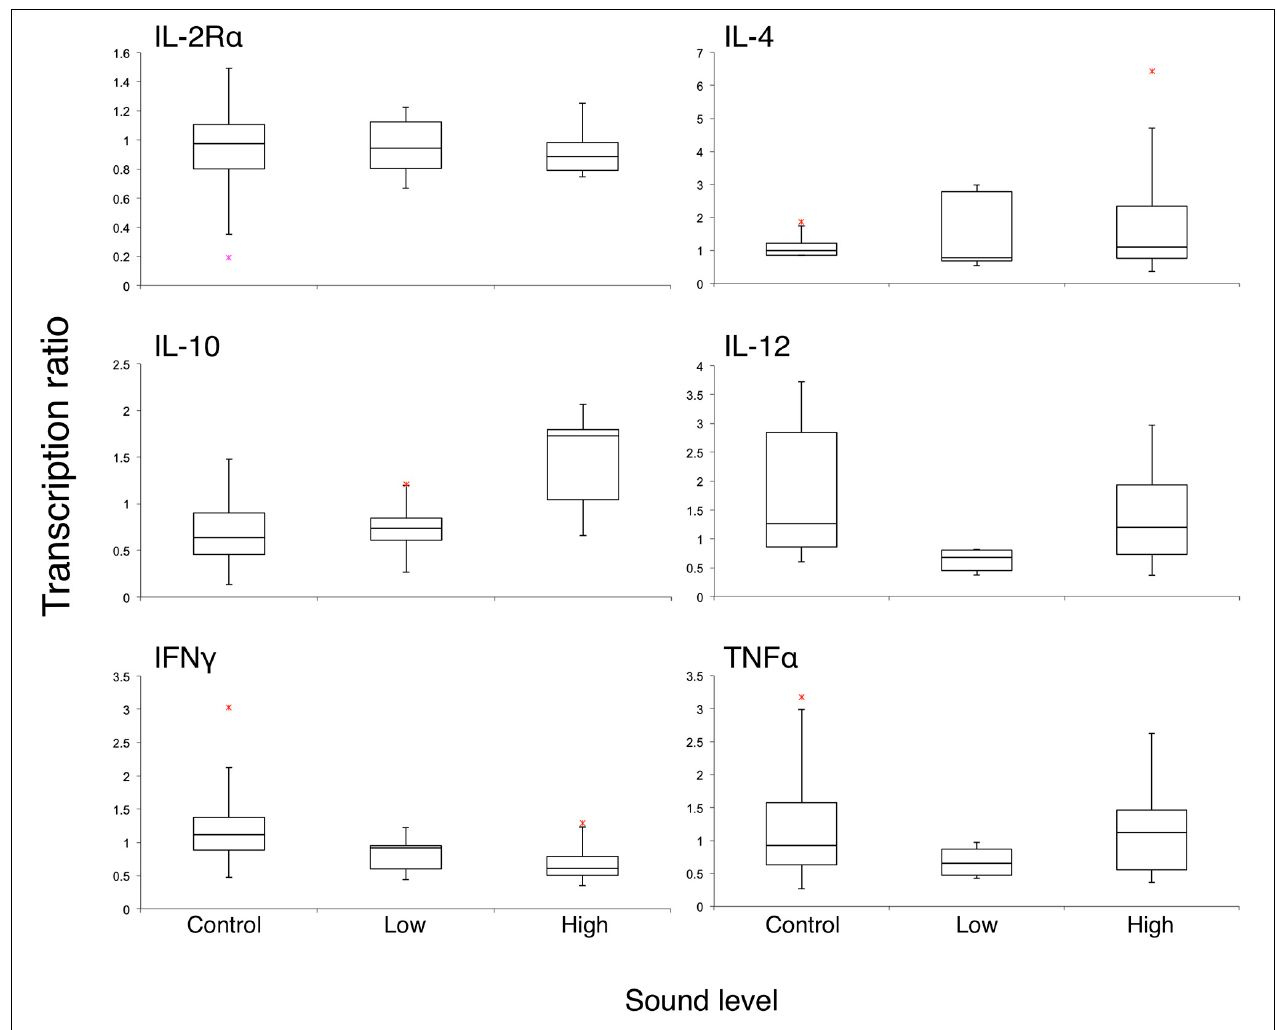
FIGURE 1 | Box plot of transcription ratios of six immunologically relevant genes of two-dolphin pooled data from three different sound levels. Red asterisks are outliers defined as values more than the third quartile + 1.5 × IQR or less than the first quartile – 1.5 × IQR, where IQR is the interquartile